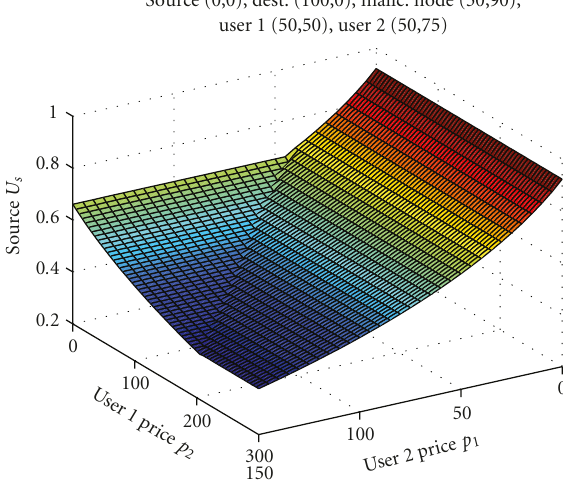
Figure 4: U s versus the prices of both